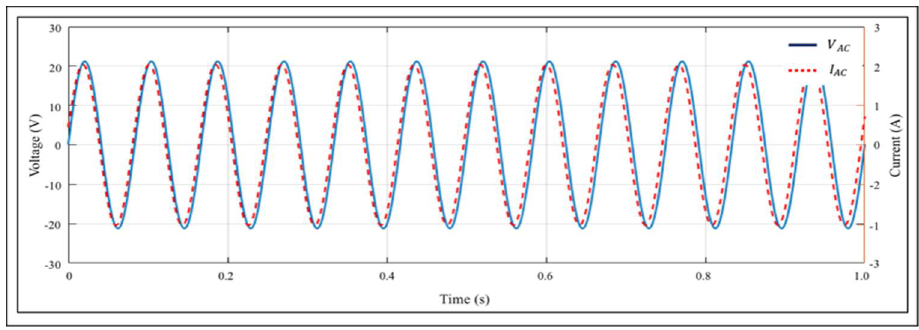
Figure 4. The waveform of V AC and I AC when the inductive load is connected. Table 1. Power system parameters.